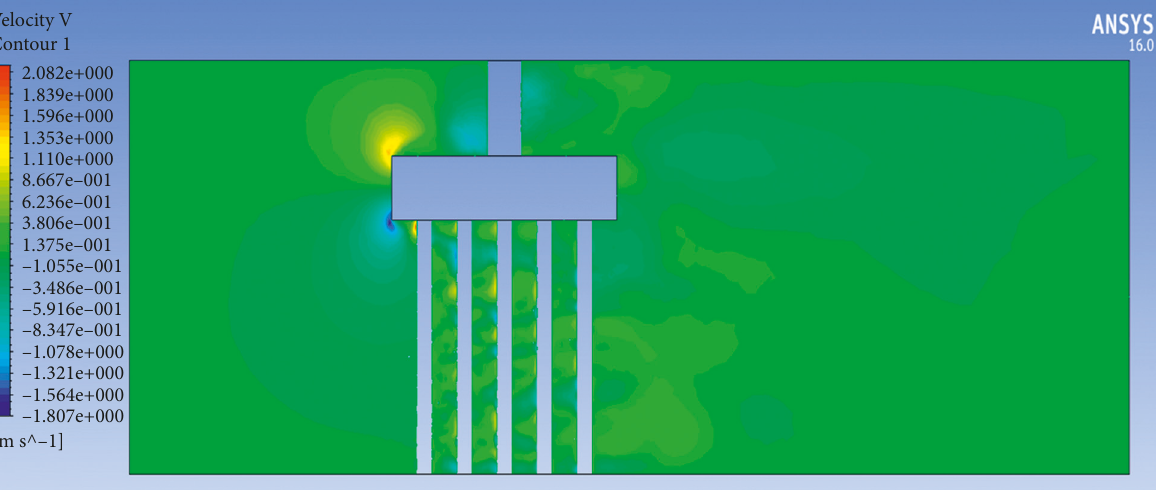
Figure 14: Distribution of vertical flow velocity at the current section.